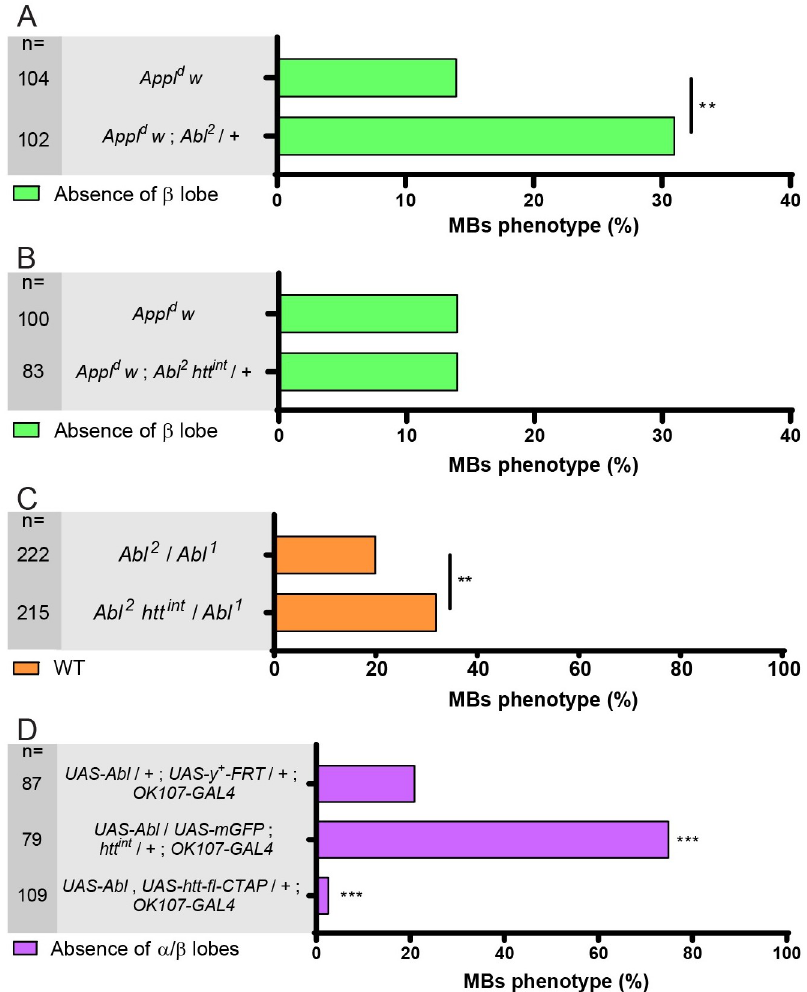
Fig 4. htt interacts with Abl . (A) The Appl d mutant phenotype is enhanced in an Abl 2 /+ mutant background. (B) However, the Appl d mutant phenotype is not modified in an Abl 2 htt int / + + mutant background. (C) The Abl 2 / Abl 1 mutant phenotype is partially rescued by the loss of one copy of htt as inferred by the increase of the wild-type (WT) MBs. (D) The absence of α and β lobe phenotype observed in UAS-Abl driven by OK107-GAL4 is strongly increased by the loss of one copy of htt (upper and middle bars). However, this phenotype is rescued by the overexpression of full- length htt (upper and lower bars). n = number of MBs analyzed, �� P < 0.01 and ��� P < 0.001. Significance was calculated by a Chi 2 test for A-C and by a multiple comparison Fisher’s exact test (P = 3.4 10 − 28 ) followed by post-hoc Bonferroni’s multiple comparison correction (p-values = 6.3 10 − 12 and 0.0003 for D). All panels correspond to adult brains except for B which is from 48 hAPF brains. Full genotypes: (A) top to bottom: Appl d w � / Y ; c739-GAL4 UAS- mito-GFP / + . Appl d w � / Y ; c739-GAL4 UAS-mito-GFP / +; Abl 2 / + . Appl d w � / Y; c739-GAL4 UAS-mito-GFP / + ; Abl 2 FRT2A htt int / + . (B) top to bottom: y w 67c23 ;; Abl 2 FRT2A / Abl 1 FRT2A . y w 67c23 ;; Abl 2 FRT2A htt int / Abl 1 FRT2A . (C) top to bottom: y w 67c23 / Y; UAS-Abl / +; UAS-FRT-y+-FRT / +; OK107-GAL4 / + . y w 67c23 / Y; UAS-Abl / UAS- mCD8-GFP; htt int / +; OK107-GAL4 / + . y w 67c23 / Y; UAS-Abl , UAS-htt-fl-CTAP / +;; OK107-GAL4 / +. Note that UAS-FRT-y+-FRT and UAS-mito-GFP are used here as neutral UAS to adjust for 2 UAS sequences in the three different